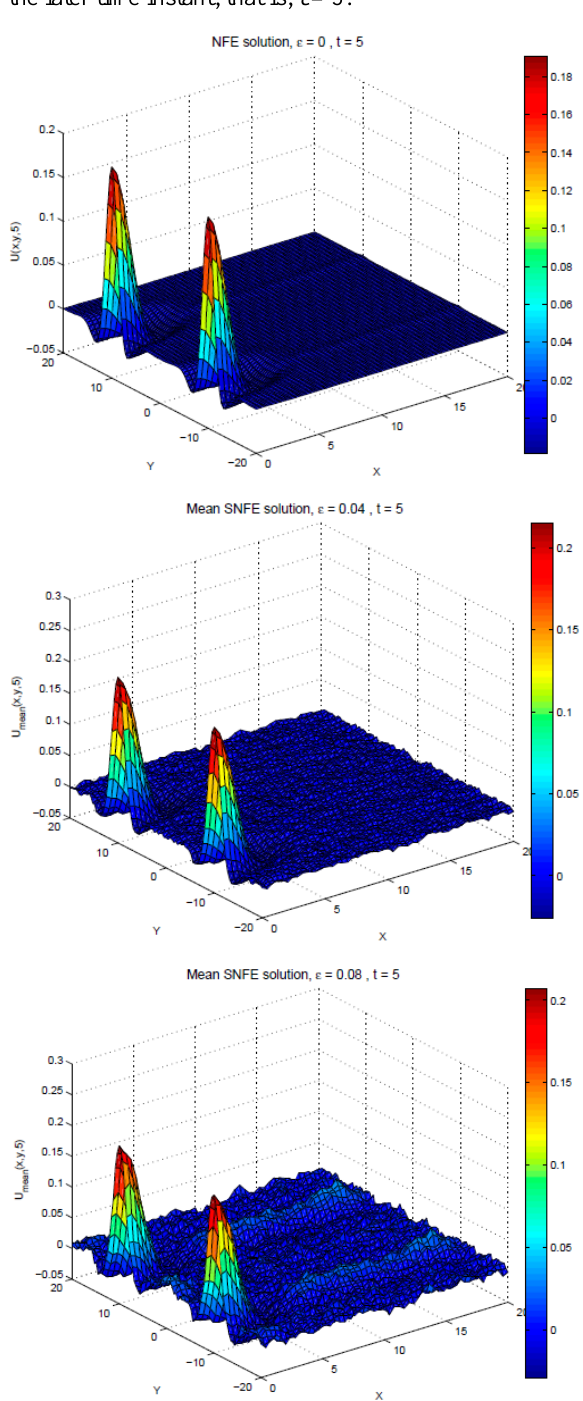
Figure 10. Snapshots of the solution of Example 2 at time t = 5: up- E = 0; down, left-hand side -E = 0.04; down, right- hand side - E =